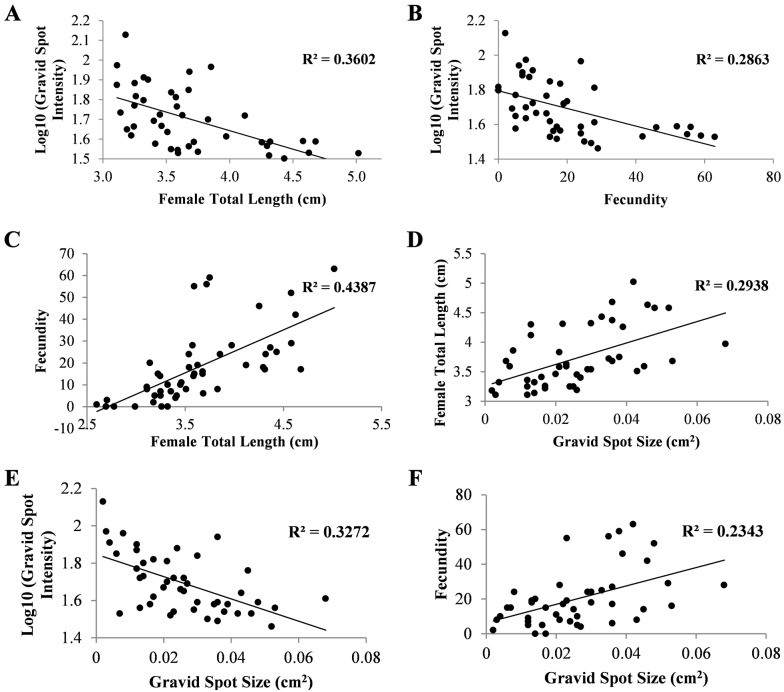
Relationship between (A) gravid spot intensity and female size (total length); (B) gravid spot intensity and fecundity; (C) fecundity and female size (total length); (D) female size (total length) and gravid spot size; (E) gravid spot intensity and gravid spot size and (F) fecundity and gravid spot size.Note: Higher and lower intensity values represent lighter and darker coloration respectively.